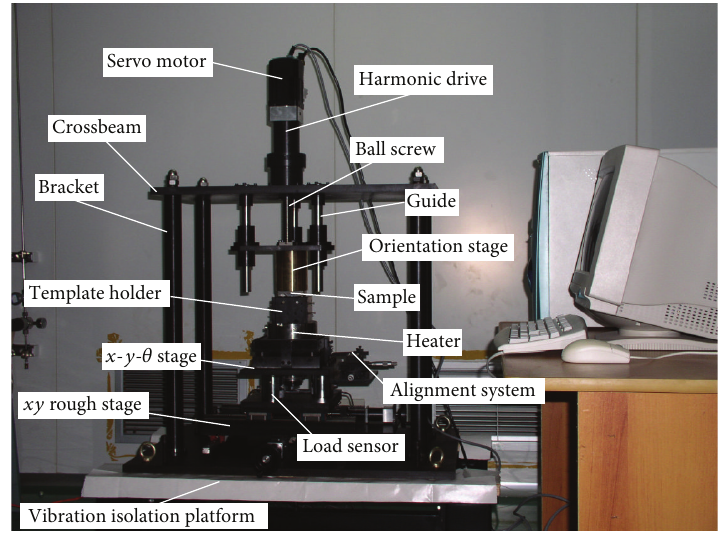
Figure 12: Microcompression molding